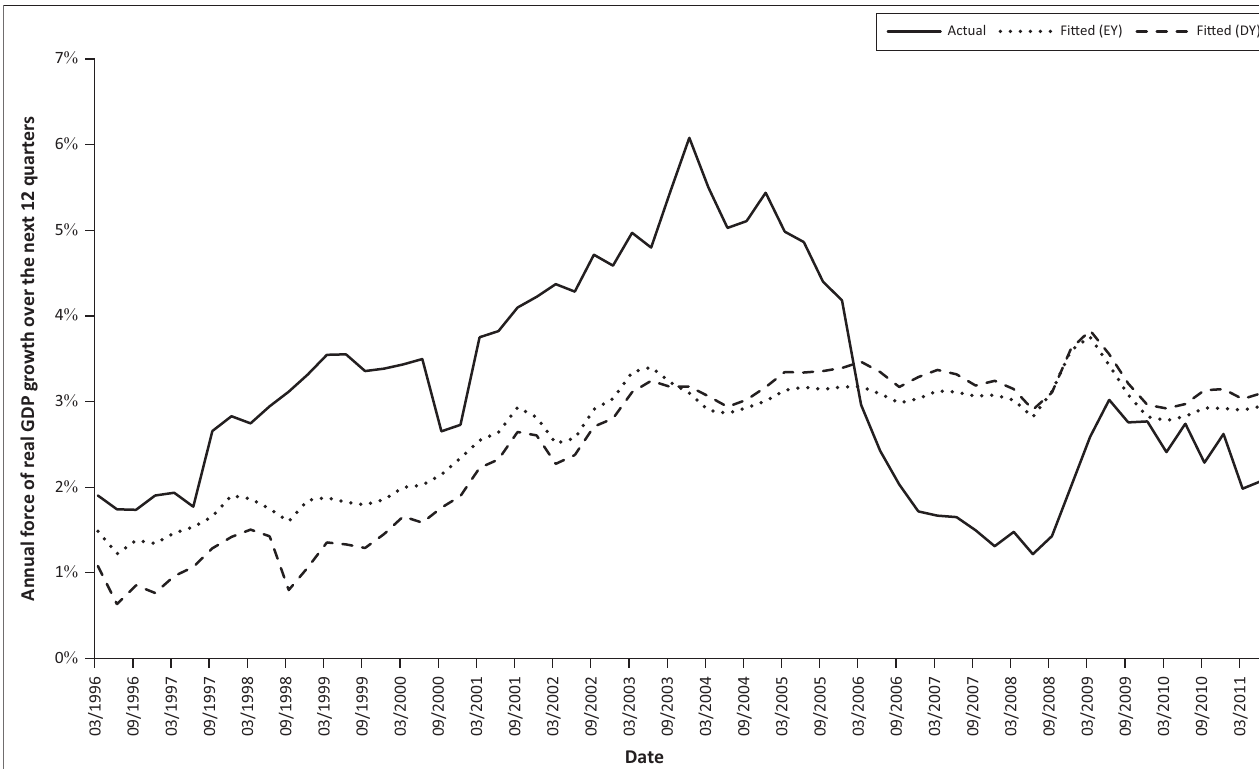
FIGURE 2: Plot of annual forces of real gross domestic product over a 12 quarter ahead period.